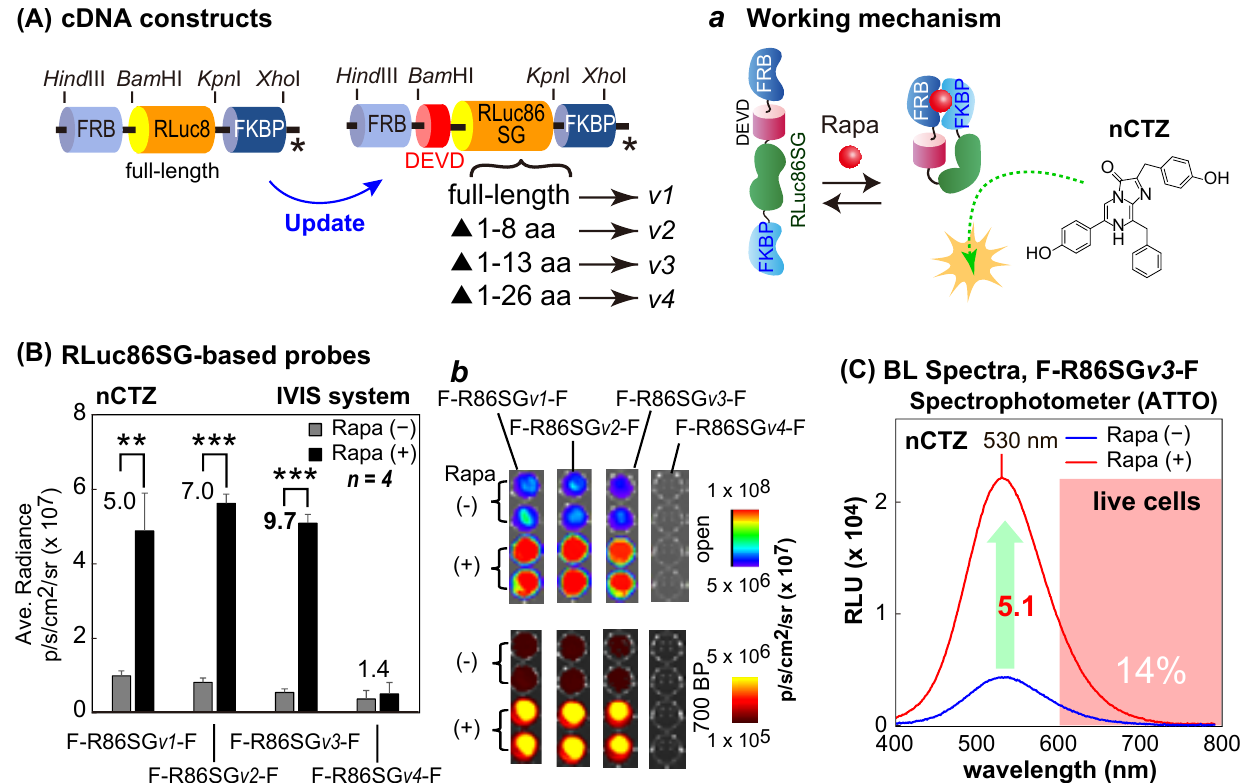
Figure 2. Kim et al.